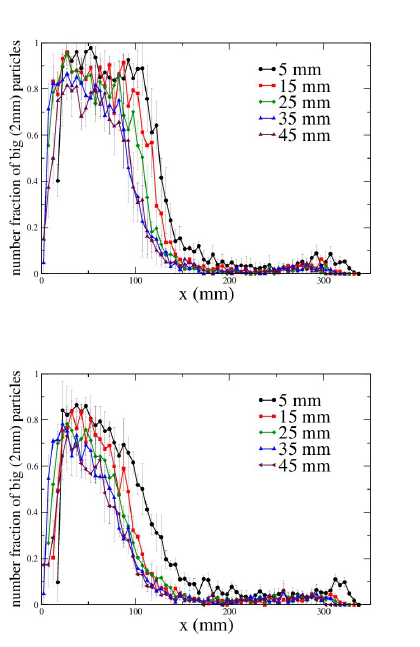
Figure 7. E ff ect of height of fall: Height of divider from bottom (h): 22 cm & 28 cm, volume of pouring 150 g